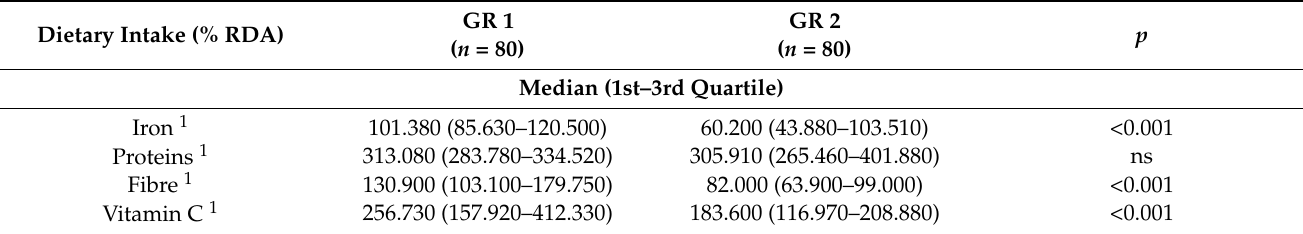
Table 7. Dietary intake in